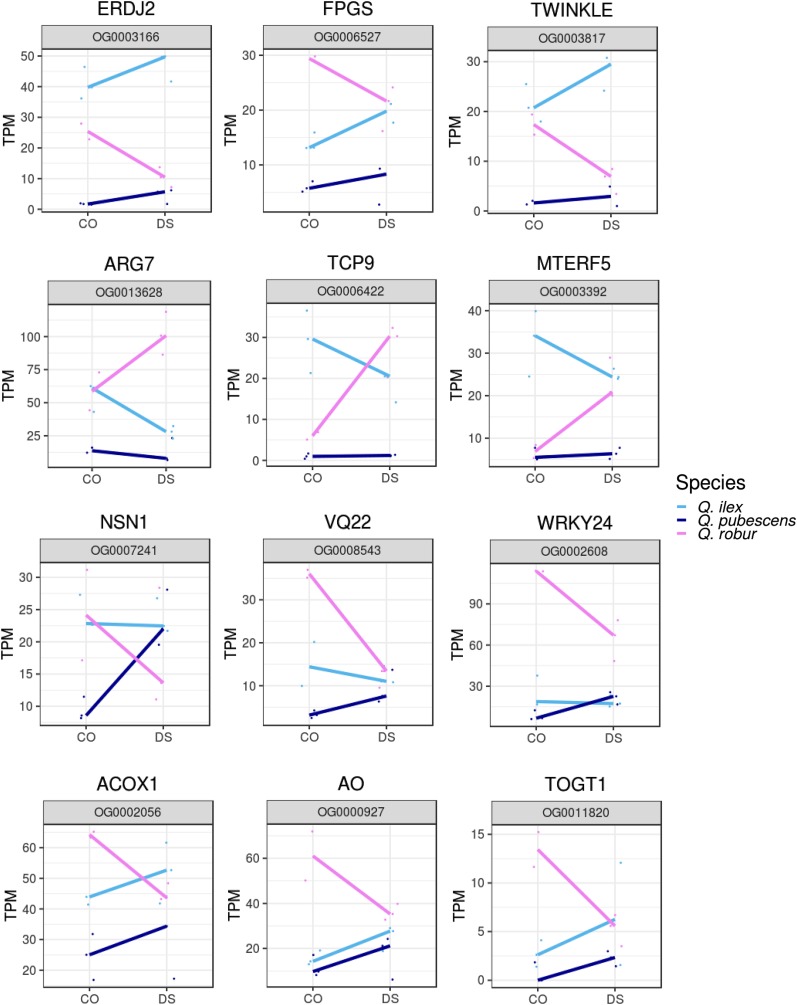
Gradually different response in Quercus species. Normalized expression values (TPM) of drought stressed (DS) and control (CO) samples of selected orthologous genes that behave gradually different in Quercus species during DS are shown.